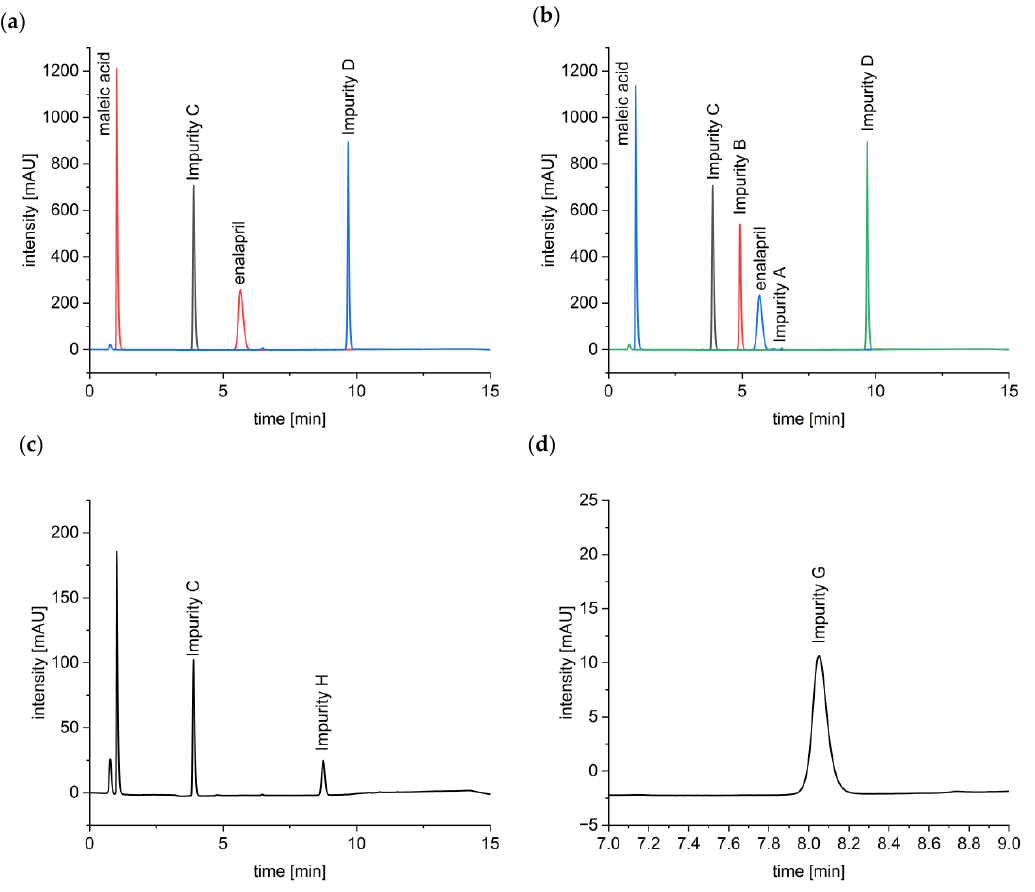
Figure 2. HPLC chromatograms of EM and the main degradation products Imp-C and Imp-D ( a ), of EM and Imp-A, Imp-B, Imp-C and Imp-D ( b ), of Imp-C and Imp-H ( c ) and of Imp-G ( d ). The identification of the related substances was done with solutions of each standard.